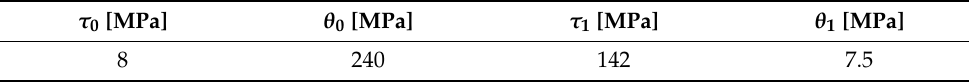
Table 1. The parameters of the reference simulation (pure Nickel, cf. [44,46]).